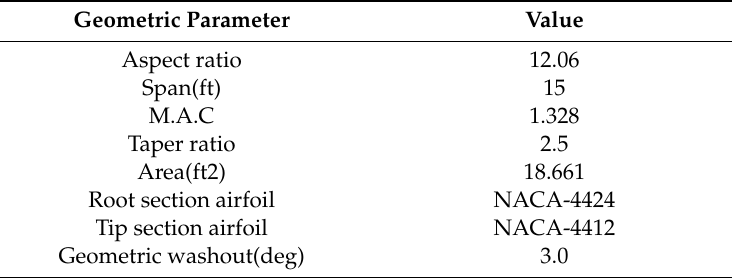
Table 3. Geometric parameters of NACA-4424-12 test wing.